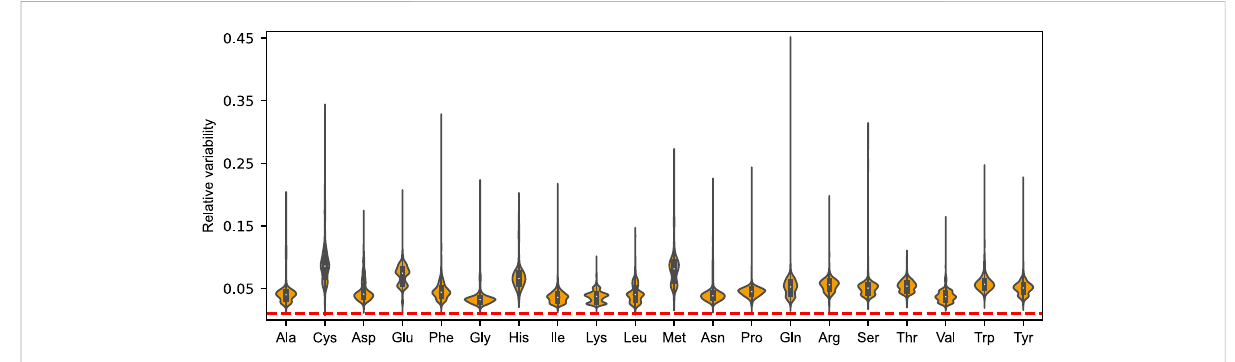
FIGURE 4 Violin plots of the distributions of mean-normalized fl ux ranges across N = 5, 000 sampled nutrient combinations for the 20 proteinogenic aminoacidsoftheacidFBAmodel.Thefeasible fl uxrangesweresimulatedbyperforminga fl uxvariabilityanalysis(FVA)usinganoptimalitythreshold of 99%. Dotted line in red denote the selected deviation from growth optimality.